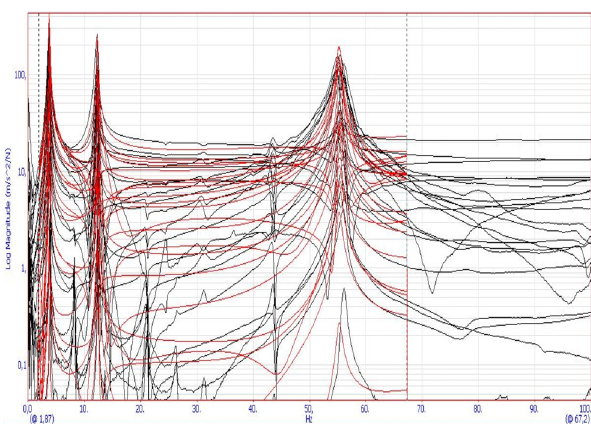
Figure 6. Modal results